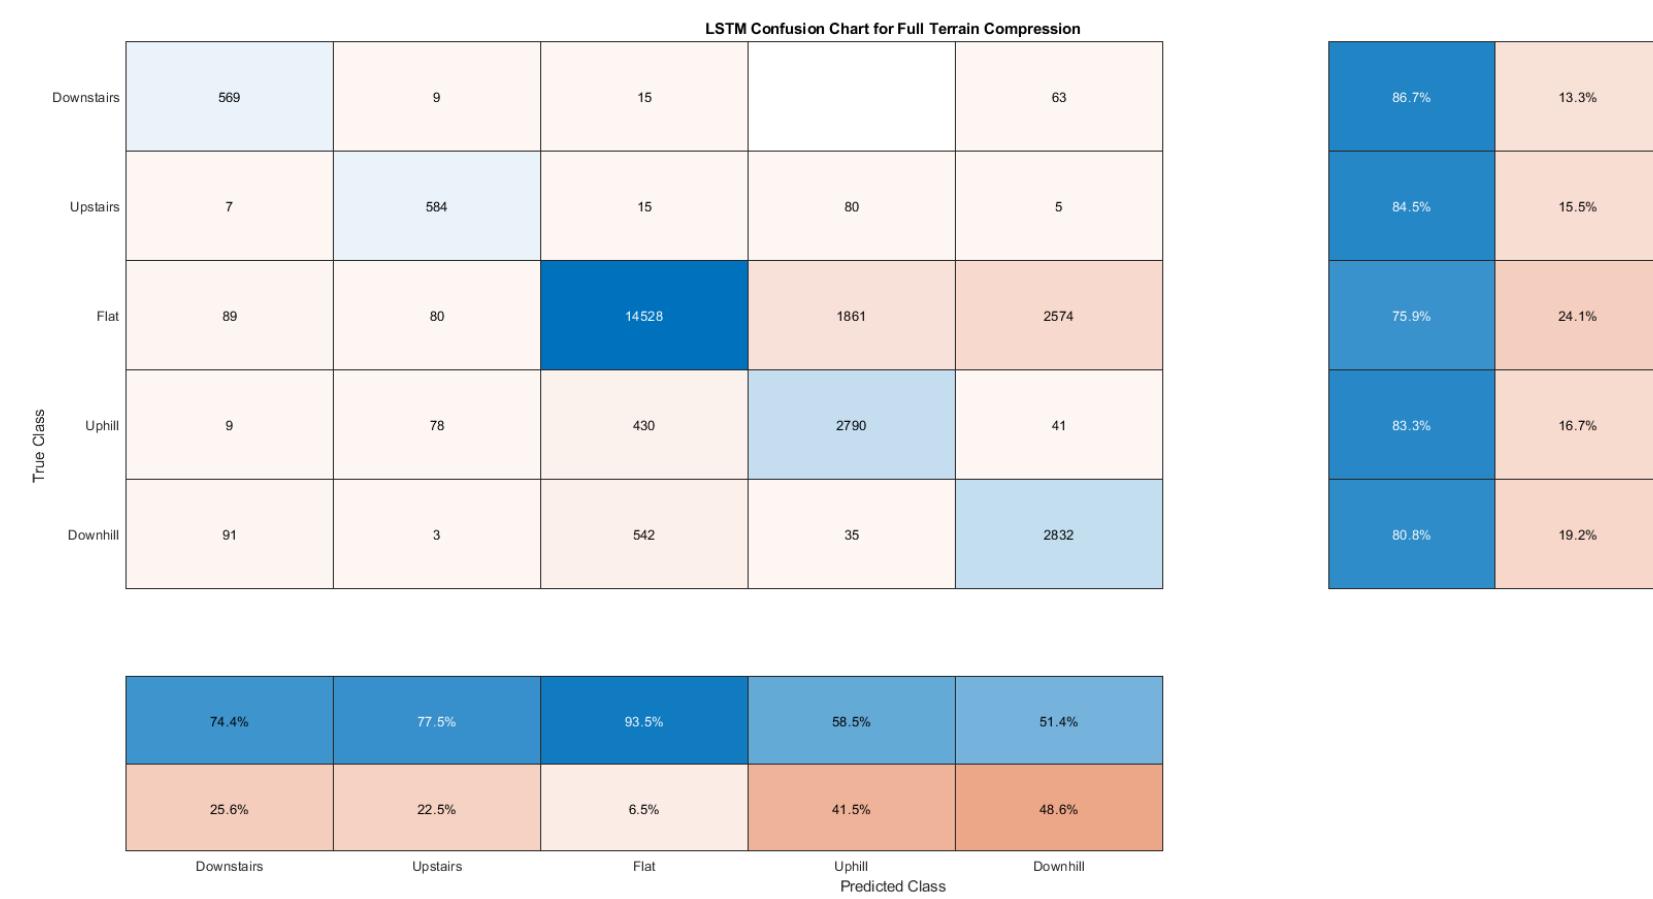
Figure A4. Long Short-Term Memory Network Confusion Chart for Level 1 label